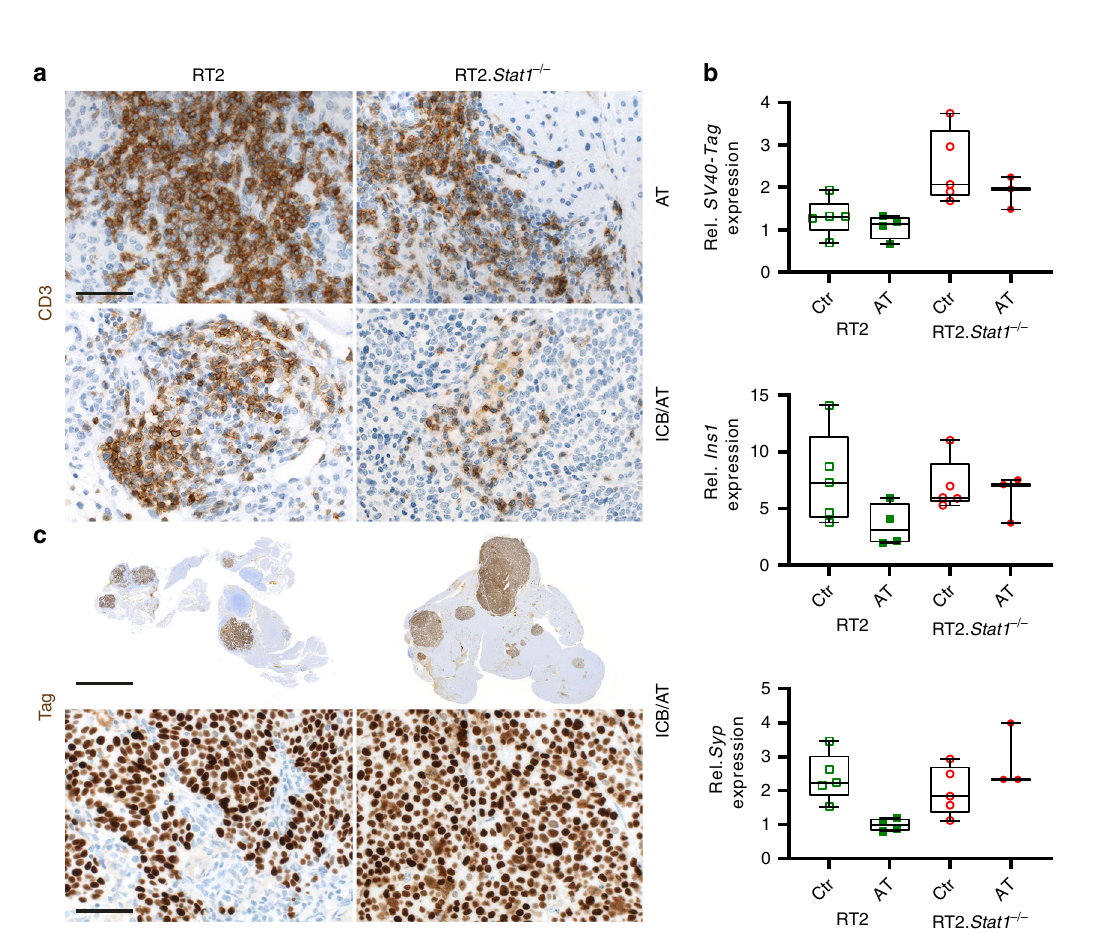
Fig. 5 In fi ltration of either RT2 or RT2. Stat1 − / − cancers by CD3 + T cells, mRNA expression of tumour associated antigens (TAA) and protein expression of the SV40-Tag tumour antigen recognised by the transferred TAA-speci fi c T H 1 cells. a Representative CD3 immune histochemistry images of RT2-cancers from either RT2 or RT2. Stat1 − / − mice treated with adoptive transfer of T antigen-speci fi c CD4 + T H 1 cells (AT) or immune checkpoint blockade combined with AT (ICB/AT), scale bar 20 µ m. b Relative expression of SV40-Tag , insulin ( Ins1 ) or of synaptophysin ( Syp ) in single tumours isolated from RT2 or RT2. Stat1 − / − mice after control (Ctr) treatment with NaCl or AT. Gene expression was analysed using Actb and Eef1a1 as references. Each point represents one tumour from one mouse (Ctr, RT2 N = 5, RT2. Stat1 − / − N = 5; AT, RT2 N = 4, RT2. Stat1 − / − N = 3), box plots show the median with 25th and 75th interquartile range (IQR), and whiskers indicate 1.5 × IQR. c SV40-Tag immune histochemistry images of RT2-cancers were from either RT2 or RT2. Stat1 − / − mice after ICB/AT therapy. Scale bar upper panel 400 µ m, lower panel 20 µ